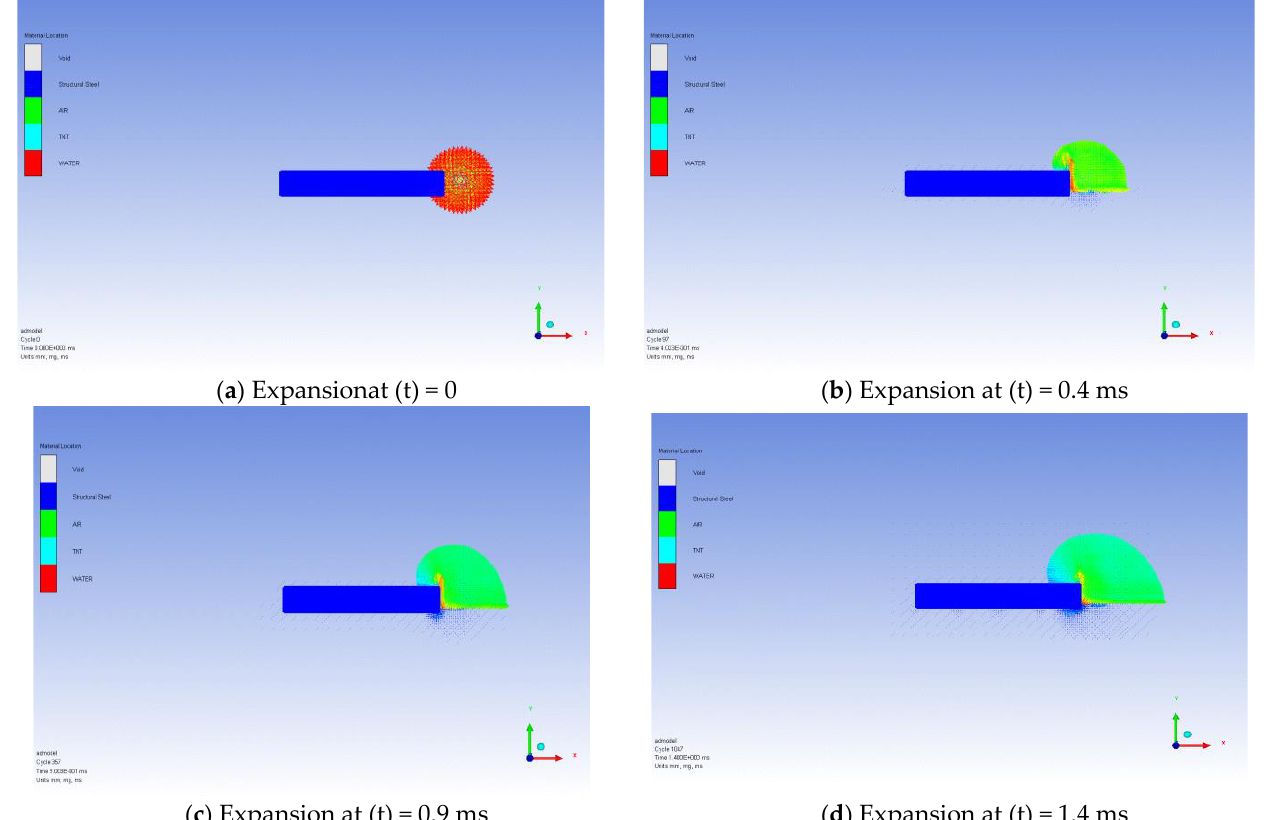
Figure 11. Expansion of the side explosion.